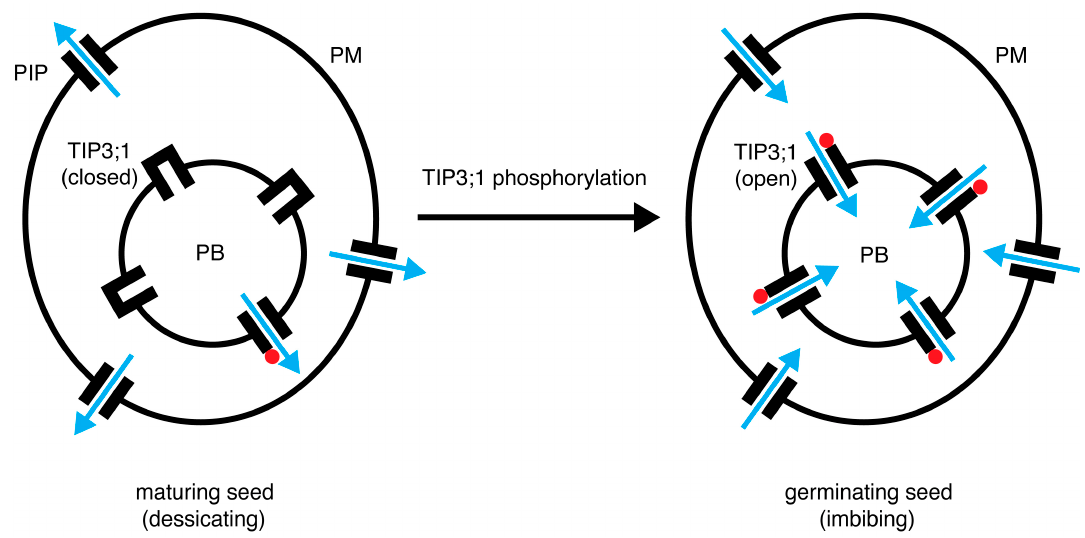
Figure 9. A model for the role of PvTIP3;1 Ser7 phosphorylation in seed development. Aquaporins may facilitate dessication during seed maturation. During seed germination, phosphorylated PvTIP3;1 facilitates the uptake of water into protein bodies. Proteolytic degradation of stored proteins supply the developing seedling with amino acids. Blue arrows show the direction of water flow, and red dots denote phosphorylation at Ser7. PIP, plasma membrane aquaporin; PB, protein body; PM, plasma membrane.